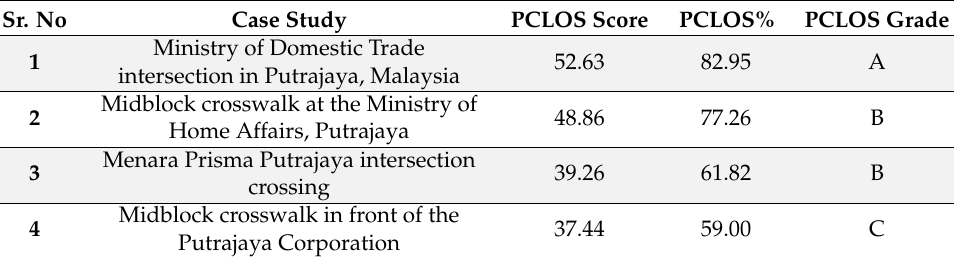
Table 5. Pedestrian crossing level of service ratings and scores for the study